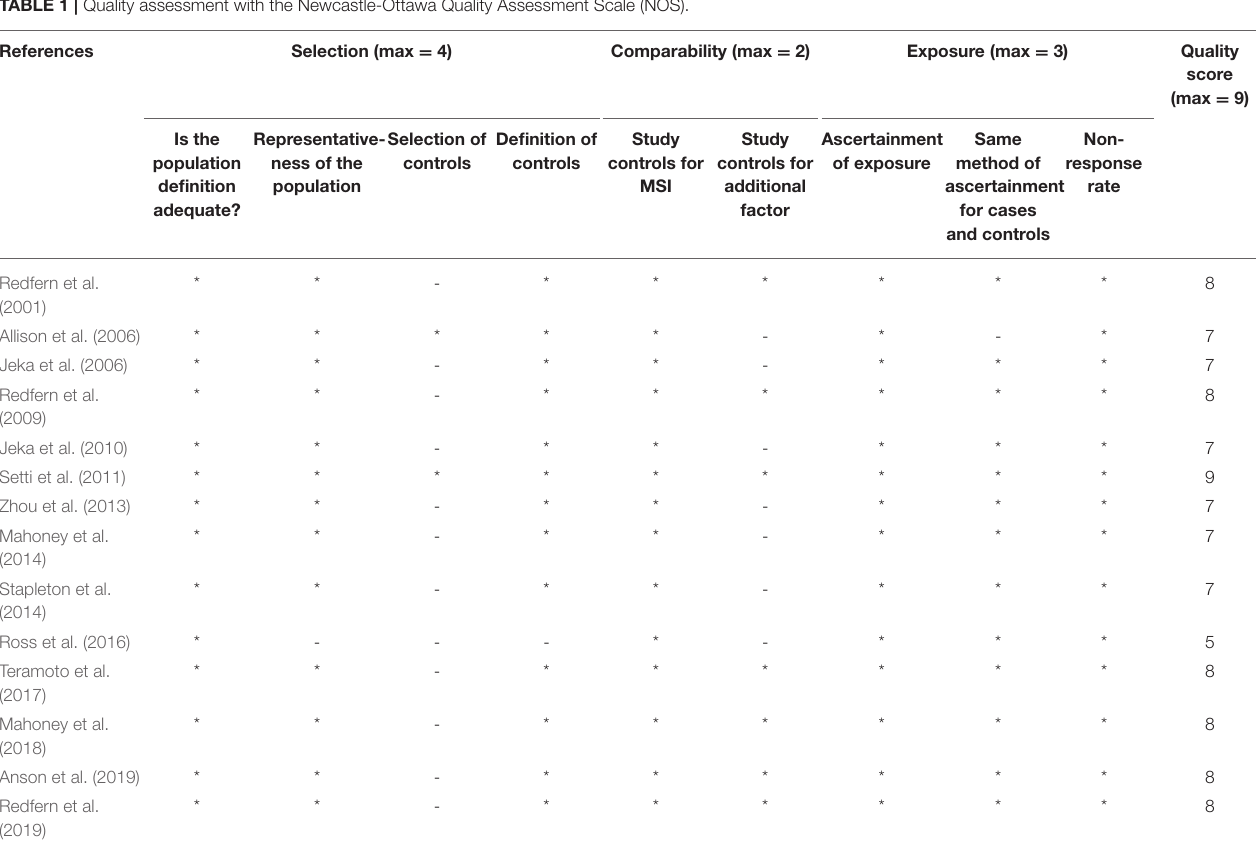
TABLE 1 | Quality assessment with the Newcastle-Ottawa Quality Assessment Scale